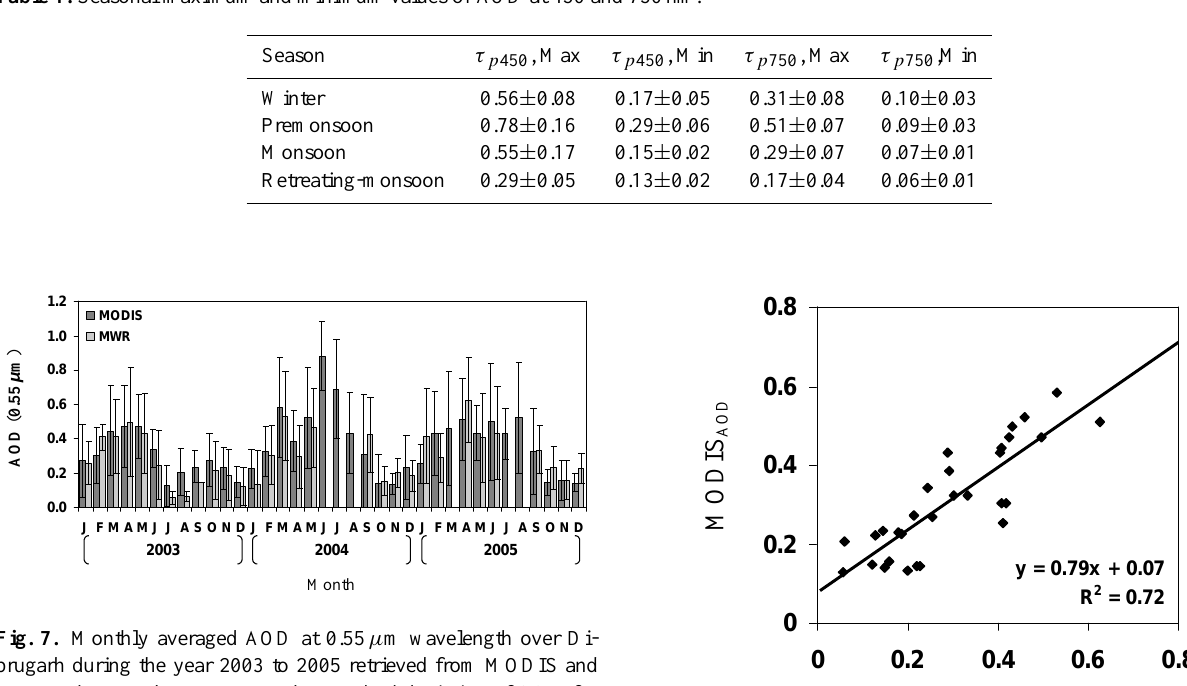
Table 1. Seasonal maximum and minimum values of AOD at 450 and 750nm.